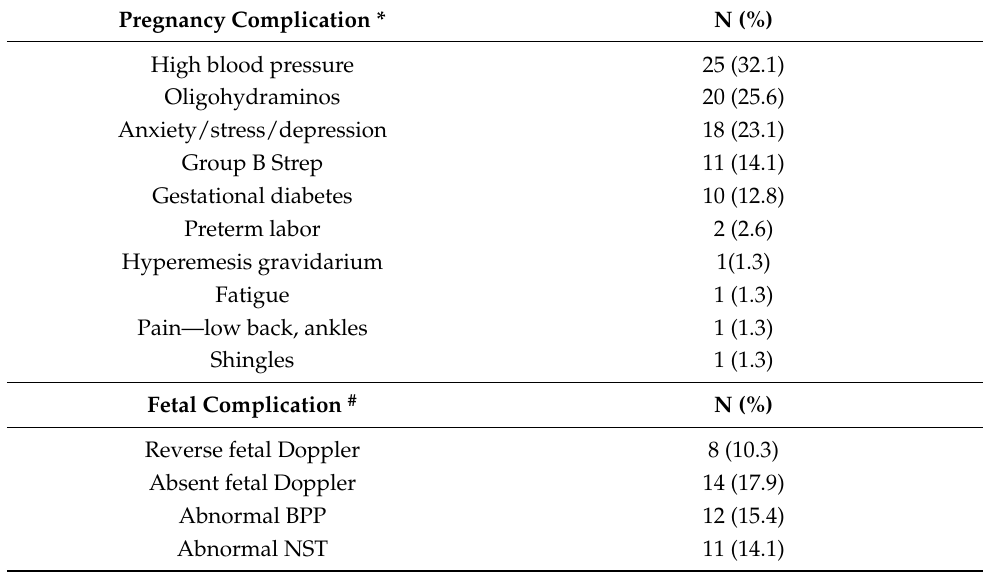
Table 2. List of pregnancy and fetal complications in conjunction with